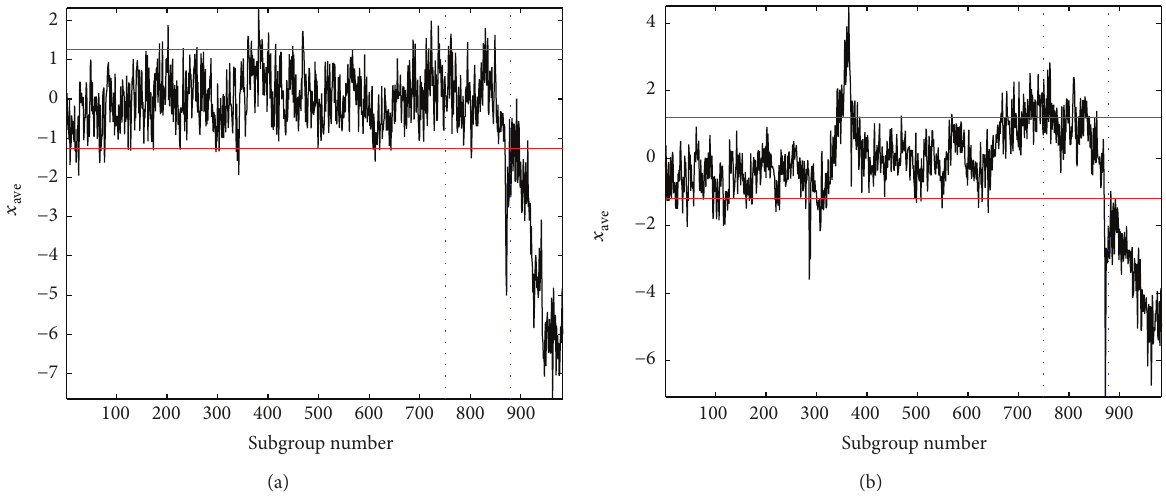
Figure 9: Shewhart control charts for damage detection using GMM (a) and a corresponding linear model